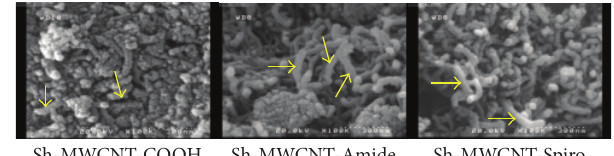
indicates carboxylic groups on the Sh-MWCNTs [16, 17].